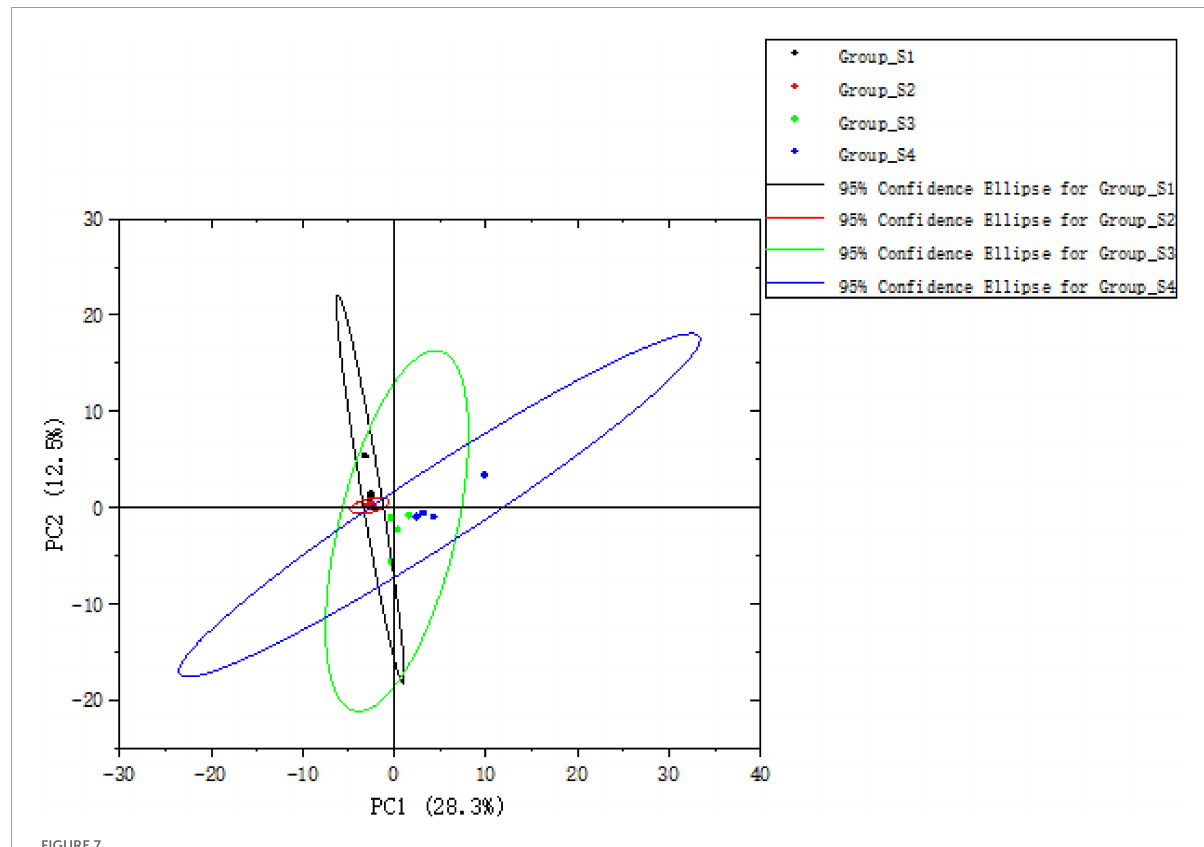
FIGURE7 The PCA score plot of total volatile compounds of fermented mutton sausage on days 0, 7, 16, and